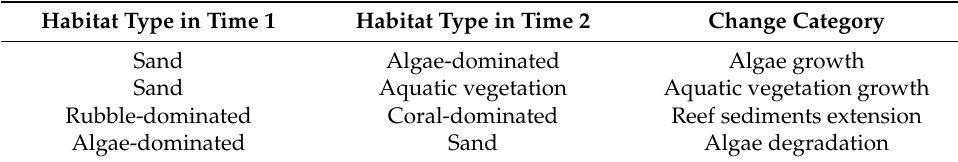
Table 3. Change category definition of Barque Canada Reef.